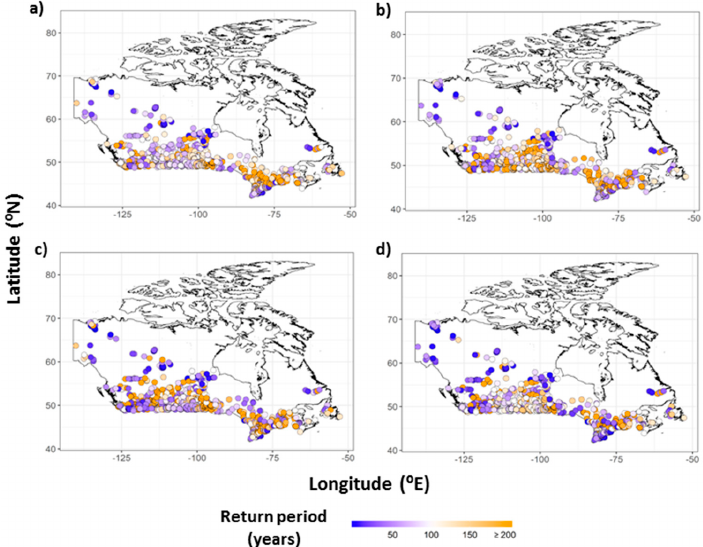
Figure 5. Future projected flooding frequencies of historical 100-year flood magnitudes at FRIs in Canada for ( a ) RCP 2.6, ( b ) RCP 4.5, ( c ) RCP 6.0, and ( d ) RCP 8.5 obtained from all GCM median.